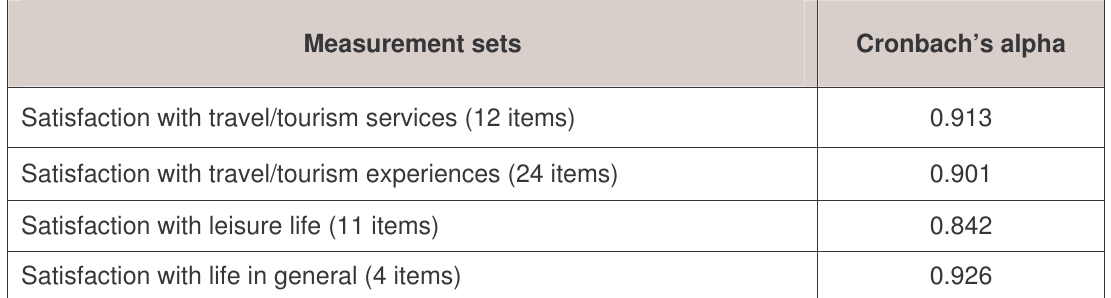
Table 1: Reliability